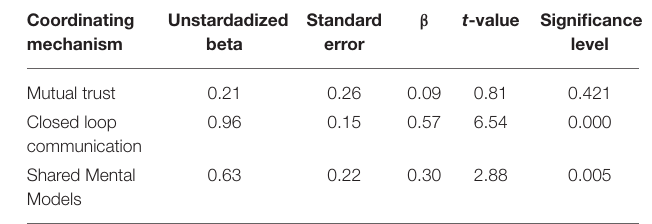
TABLE 2 | Unstandardized and standardized coefficient ( β ), standard error, t -values, and significance levels for situation awareness regressed upon team behavior.